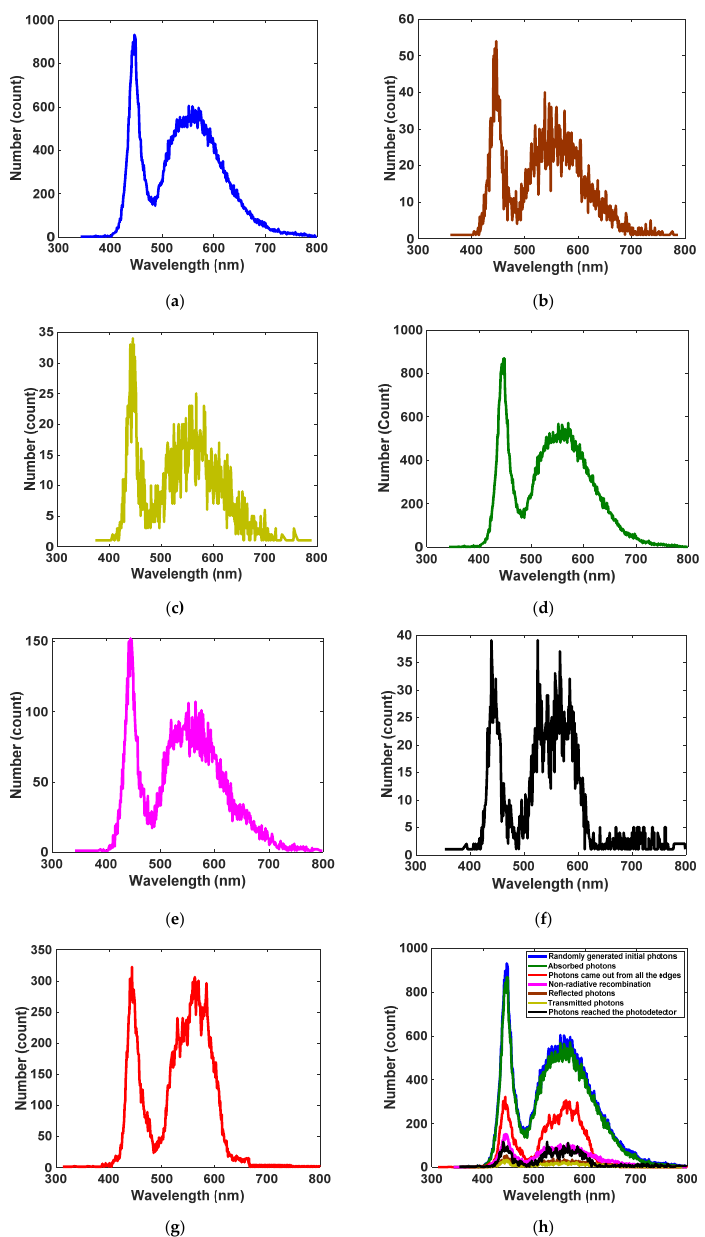
Figure 7. The obtained results in the form of spectra (number of the photons with their corresponding wavelengths) for each event occurred inside the antenna after completing the Monte Carlo